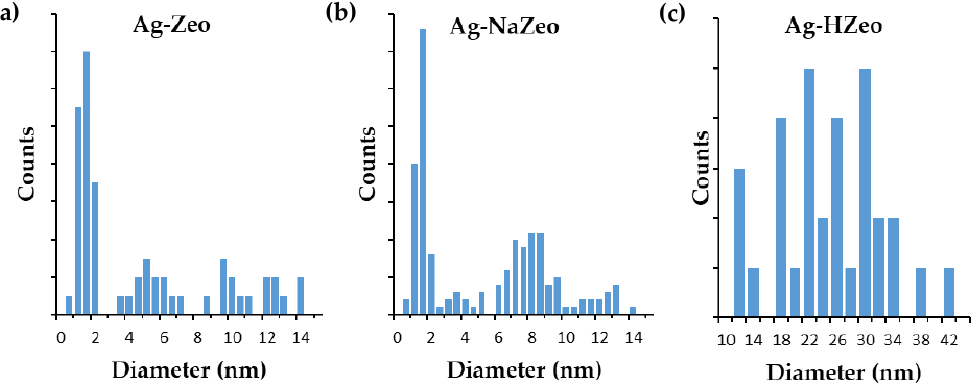
Figure 3. AgNP size distribution in silver–zeolite composites. ( a ) Ag–Zeo, ( b ) Ag–NaZeo, ( c ) Ag–HZeo